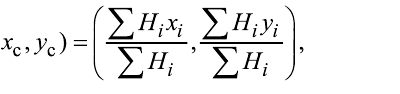
method and the proposed method. The NBs were numerically labeled by increasing areas detected by the threshold